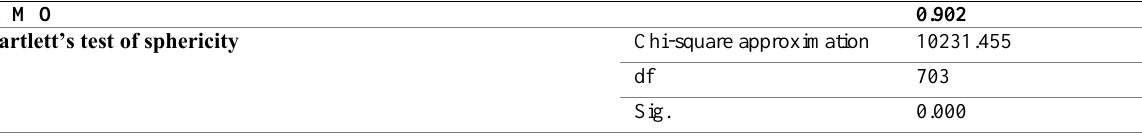
Table 2: KMO and Bartlett’s